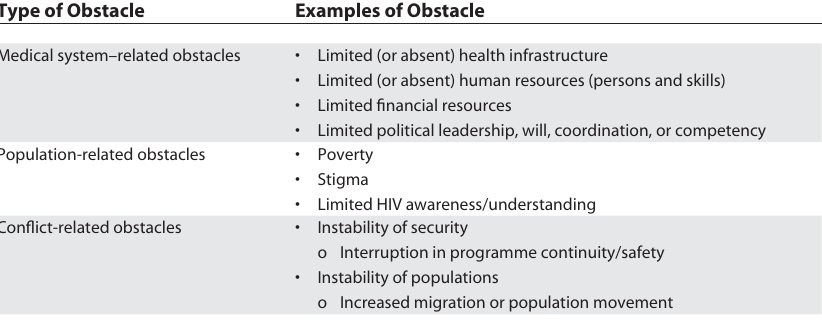
Table 1. Obstacles to Providing HIV Care in Resource-Limited Chronic Confl ict